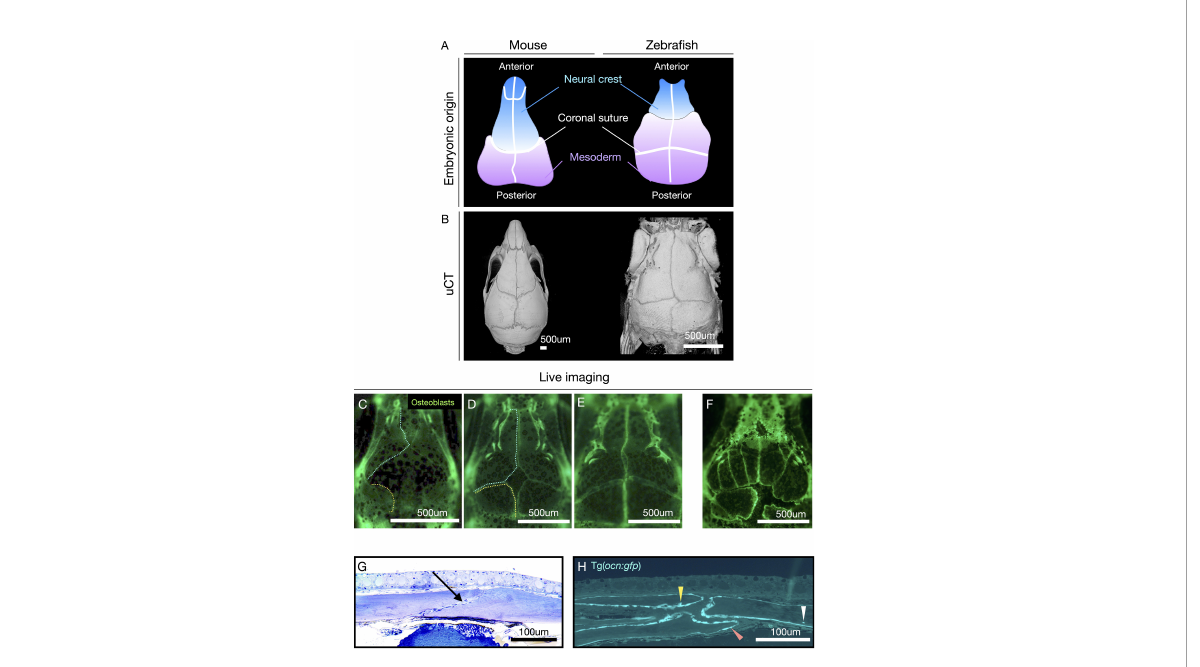
FIGURE 4 Zebra fi sh have the same sutures as mammals with the advantage of allowing the visualization of suture formation in vivo . (A) Diagram showing the contribution of neural crest (blue) and mesoderm (lilac) cells to the mouse and zebra fi sh calvariae (top panel). Note: coronal suture in zebra fi sh is formed by mesoderm/mesoderm while in mice by neural crest/mesoderm. (B) µCT of calvaria of mice and zebra fi sh. (C – E) Live imaging of wild-type (wt) zebra fi sh calvariae during suture formation using Tg( Runx2:egfp ) reporter line labeling osteoblasts. Note: osteogenic fronts of the frontal bones (cyan dashed line) and the parietal bones (yellow dashed line). Bone growth is initiated from lateral condensations and progress towards the middle of the calvaria to totally cover the brain. (F) Live imaging of sp7-/- as an example of abnormal suture patterning, and ectopic sutures. (G) Histological semi-thin section of adult male zebra fi sh, at the coronal suture, stained with Toluidine Blue. Note: in contrast to humans bones overlap at the suture. The coronal suture is indicated with an arrow. (H) Semi-thin plastic section at the sagittal suture of a 3-month-old zebra fi sh carrying the reporter line Tg( ocn:gfp ) labeling osteoblasts and osteocytes (expressing osteocalcin) (according to protocol (144)). Osteoblasts (orange arrowhead), terminal osteoblasts being immersed in bone matrix (yellow arrowhead), osteocyte embedded in bone (white arrowhead). Images (G, H) were kindly provided by the laboratory of Dr. P. Eckhard Witten. Scale bars are indicated in each